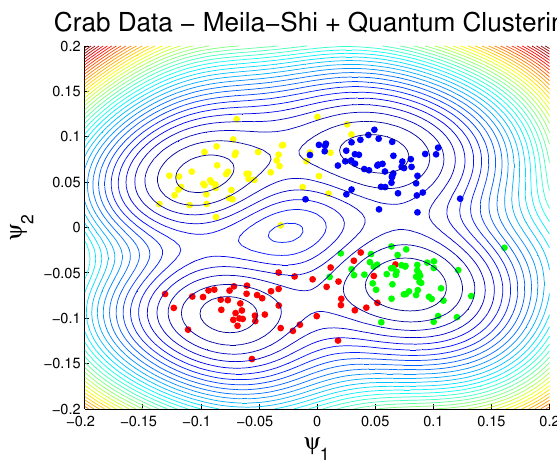
Figure 3. Identification of four classes by quantum